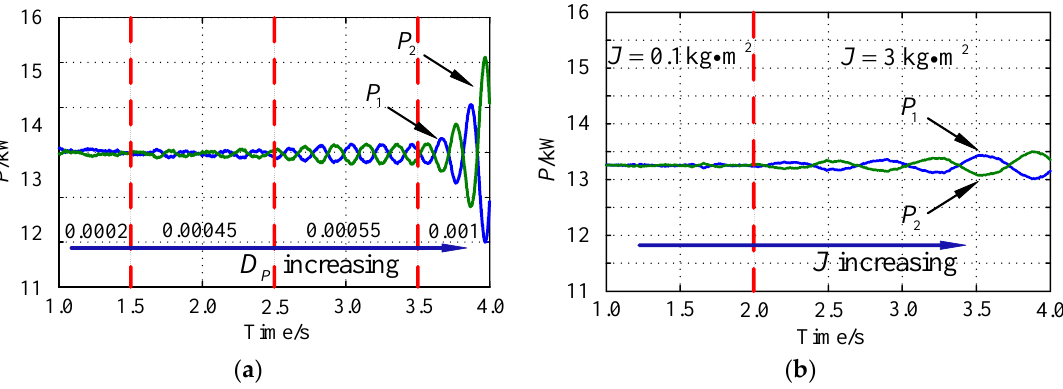
Figure 14. Effect of the key parameters on the transient performances of the active power P 1 and P 2 : ( a ) Reactive power droop coefficient D p increasing; and ( b ) Virtual inertia J increasing. (The red dotted lines are the boundaries between the two areas of different parameters.)